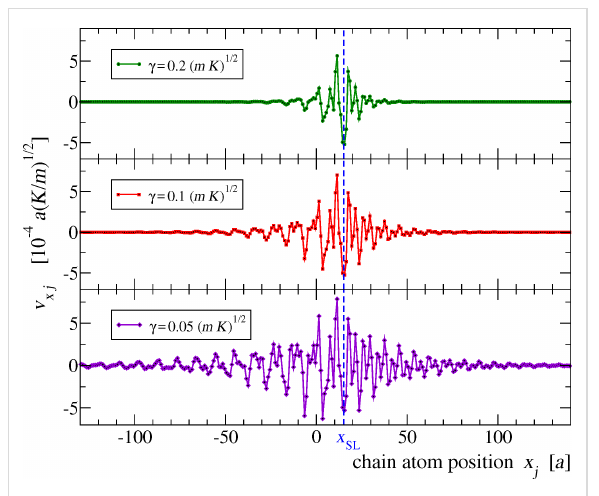
Figure 5: Three snapshots of the instantaneous velocities of a few chain atoms as a function of their position while interacting with the slider, whose instantaneous position x SL is marked by a vertical dashed line. The three calculations are executed with the same v SL = 0.1 v s , but with three different values of γ , which produce visibly different damping of the same excited phonon waves away from the interaction point.